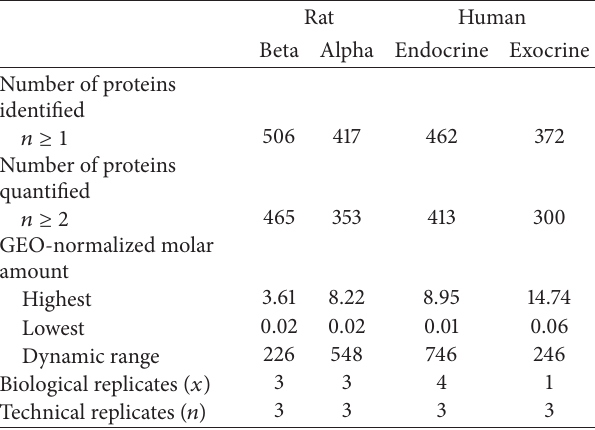
Table 1: Overview of proteome coverage by